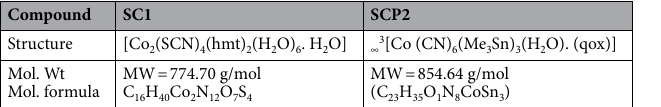
Table 2. Chemical structures of metal–organic compounds (SC1 & SCP2).